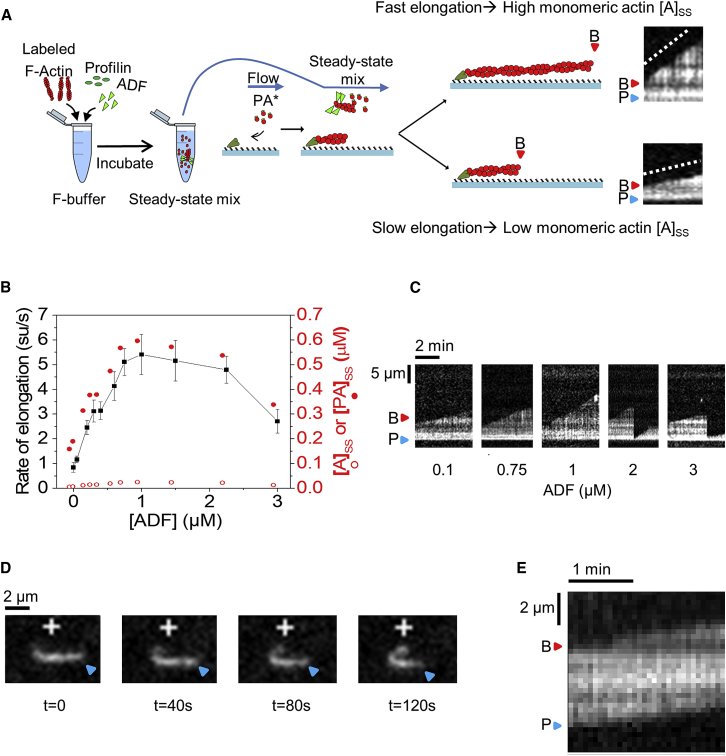
ADF Increases the Steady-State Concentration of Monomeric Actin(A) Sketch of the setup to measure the amount of steady-state ATP-monomers as a function of ADF. Tracer filament free barbed ends were exposed to solutions of pre-assembled 5 µM 10% Alexa-488-labeled F-actin, 3 μM profilin, and varying amounts of ADF at steady state (see STAR Methods). Example kymographs show fast/slow elongation as indicators of high/low values of the steady-state amount of polymerizable actin actin-monomers ([A]SS + [PA]SS). P, blue triangles, pointed ends; B, red triangles, barbed ends.(B) Elongation rate of tracer barbed ends (black squares and curve) as a function of ADF concentration. Error bars represent SD. Each data point was averaged from at least 50 filaments over three experiments; all elongation rates (except at 50 nM ADF) are statistically significant (p < 0.05; two-sample t test) compared to the control (0 ADF). Corresponding steady-state concentrations of actin monomers (profilin-actin [PA]SS, red closed circles; free G-actin [A]SS, red open circles; see Equations 5 and 6 in STAR Methods).(C) Representative kymographs.(D) Filaments from the steady-state flow (0.75 μM ADF), incidentally stuck to the coverslip surface, display barbed-end (+) elongation and pointed-end shrinkage (see Movie S5).(E) Kymograph showing constant filament length maintained during treadmilling. B and P indicate the two ends.